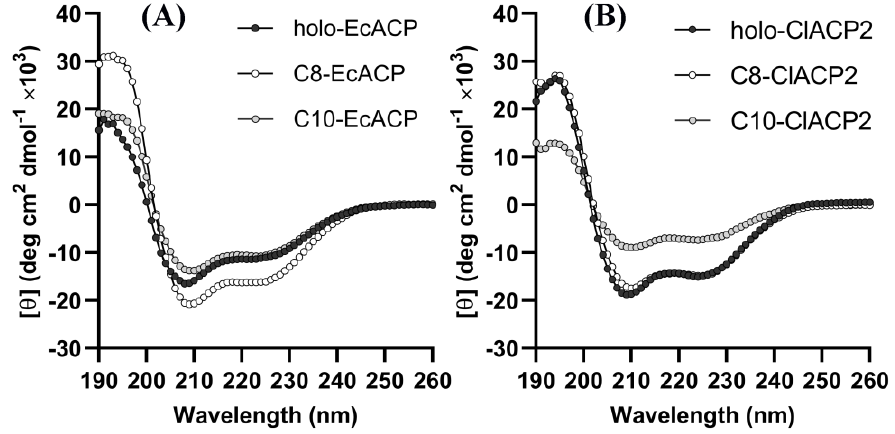
Figure 3. Circular dichroism spectra of the ACPs ( A ) holo-, C8-, and C10-EcACP from 190 to 260 nm wavelength. ( B ) holo-, C8-, and C10-ClACP2 from 190 to 260 nm wavelength. The mean residue ellipticity (θ) in degrees cm 2 dmol −1 .